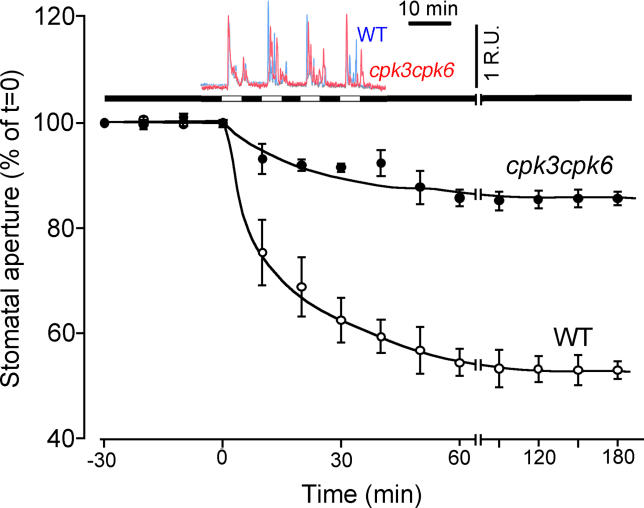
Ca2+-Reactive Closure Is Impaired in cpk3cpk6 Double Mutant StomataFour [Ca2+]cyt transients (inset) were imposed in wild-type (WT) (n = 6 experiments) and cpk3-1cpk6–1 double mutant (n = 6 experiments) stomata. Individually mapped stomatal apertures were measured for the last 30 min before imposed [Ca2+]cyt transients (before Time = 0) and for the ensuing 180 min at the indicated time points. Error bars represent SEM. Inset (top) shows imposed [Ca2+]cyt transients in wild-type (blue trace) and in cpk3-1cpk6–1 (red trace) guard cells expressing Yellow Cameleon 3.6 (R.U.: ratio units).